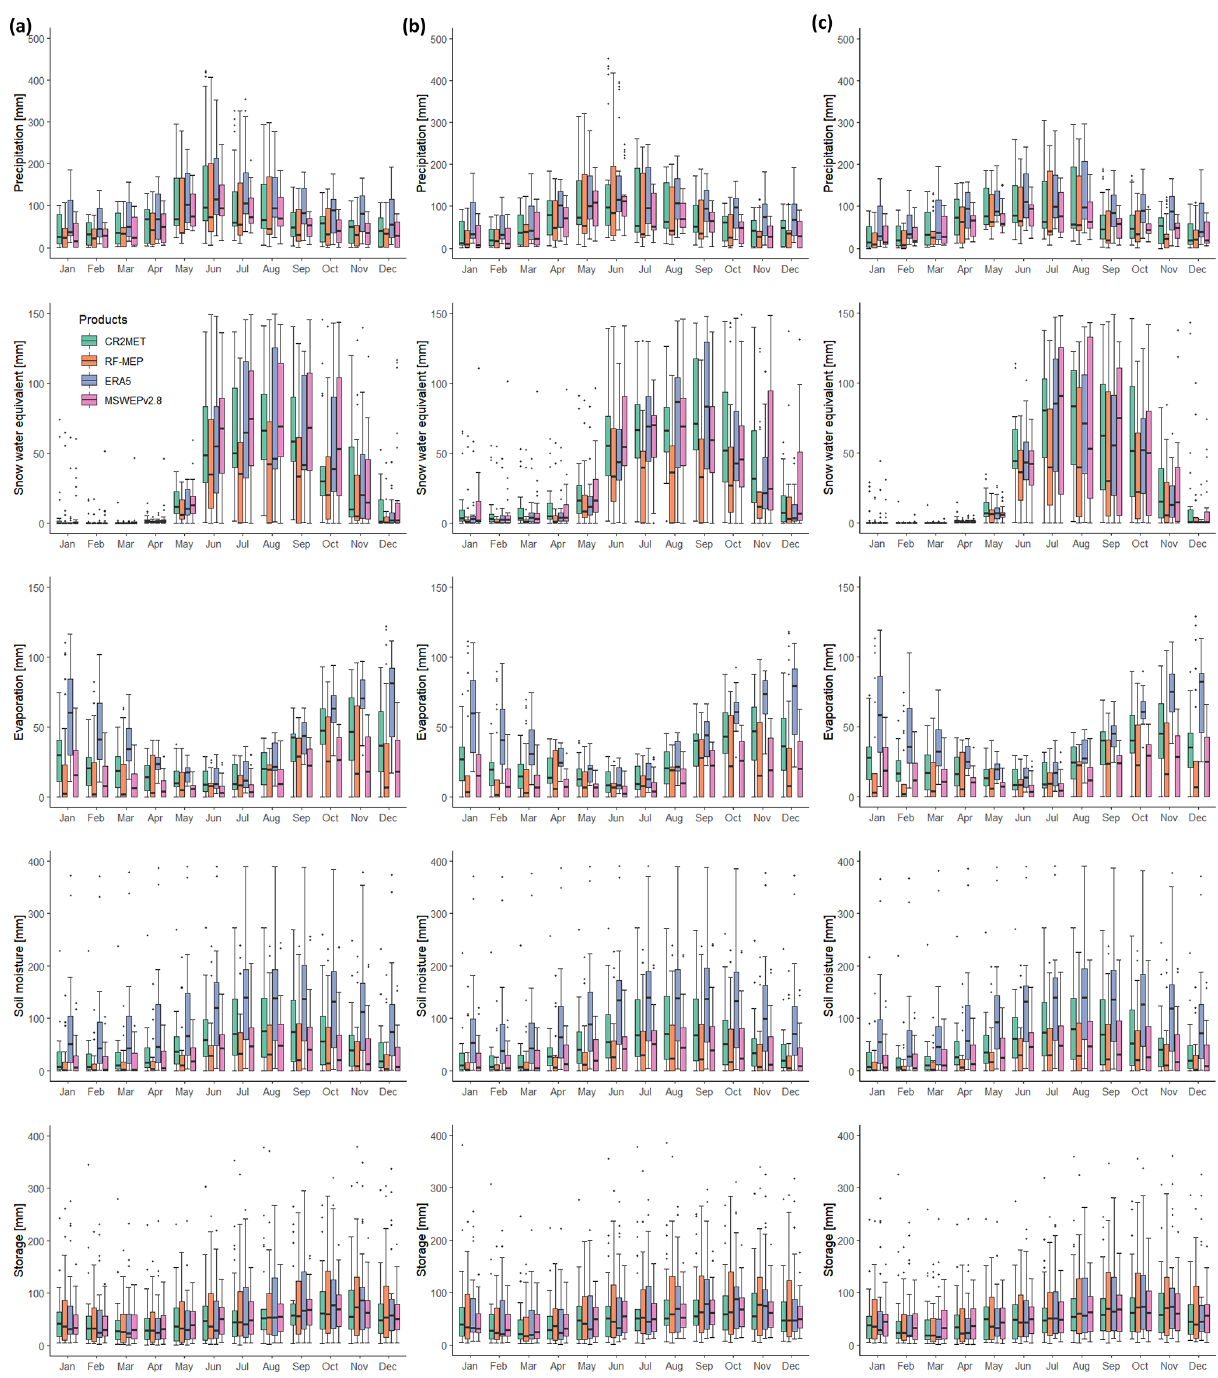
Figure 13. Mean monthly water balance components over nivo-pluvial catchments, obtained by forcing the TUW model with different P products for the (a) calibration (2000–2014), (b) Verification 1 (1990–1999), and (c) Verification 2 (2015–2018) periods. Mean monthly P was added for comparison